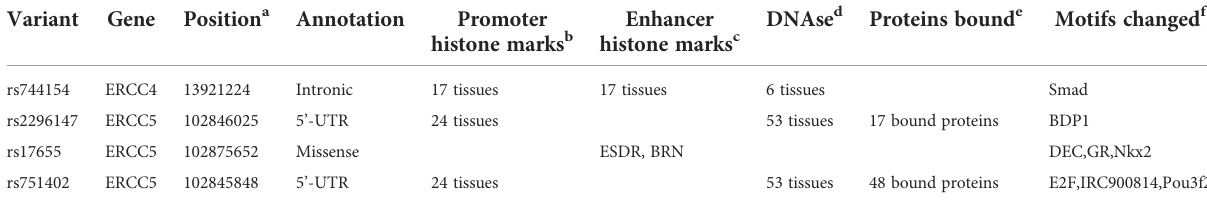
TABLE 3 Summary of functional annotations for four single-nucleotide polymorphisms in ERCC4 and ERCC5 with fi ve cancer sites risk (strong epidemiological credibility).